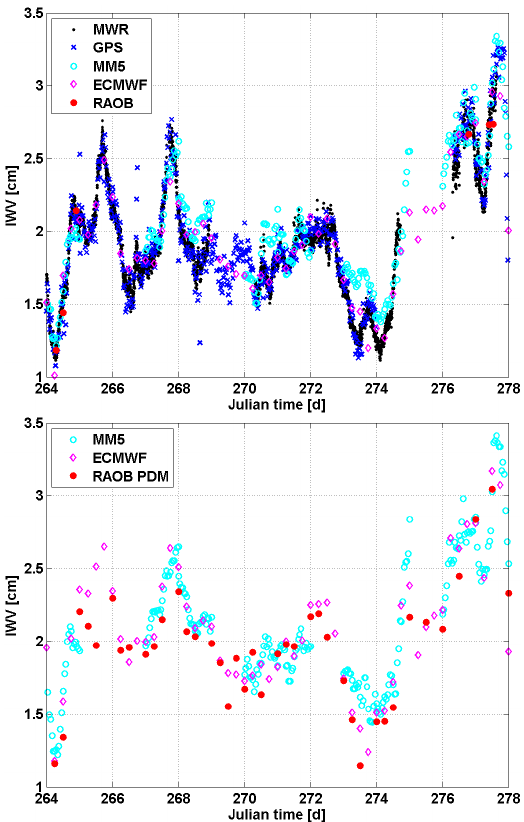
Fig. 3. Time series of IWV from MWR (black dots), GPS (blue x), MM5 (cyan circles), ECMWF (magenta diamonds), and RAOB (red solid circles). Top: at DIESAP. Bottom: at